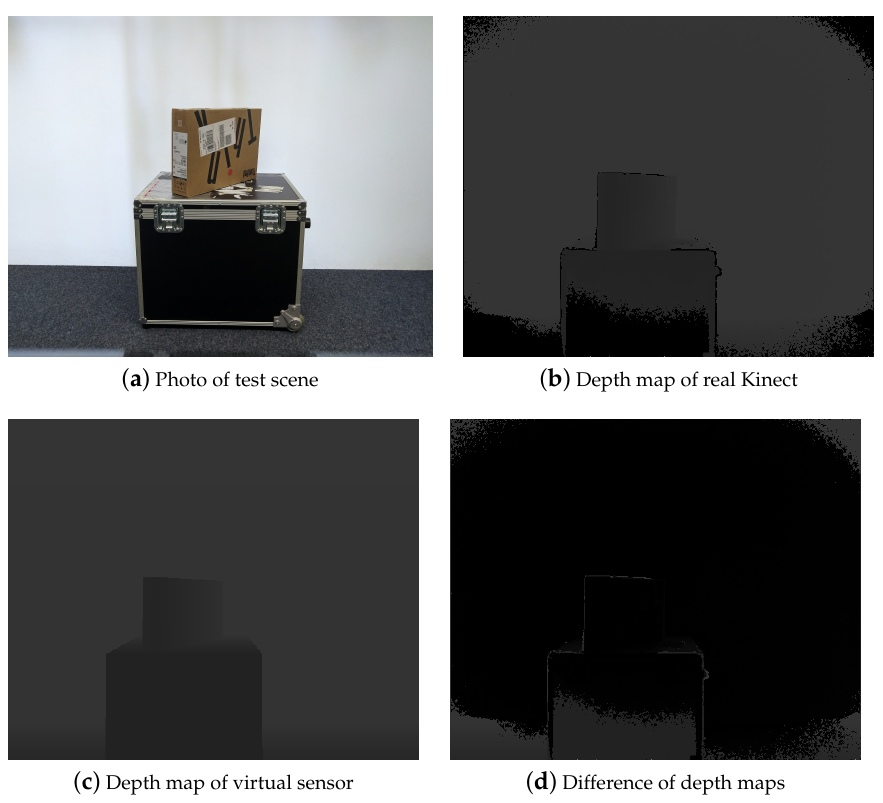
Figure 16. ( a ) Simple real-world test scene with two stacked boxes. ( b ) Depth map acquired by the Kinect v2. Vignetting effects at the periphery and edge noise can be observed as black pixels. ( c ) Depth map acquired by a virtual sensor with a simple 3D model of the test scene. ( d ) Difference image of the two depth